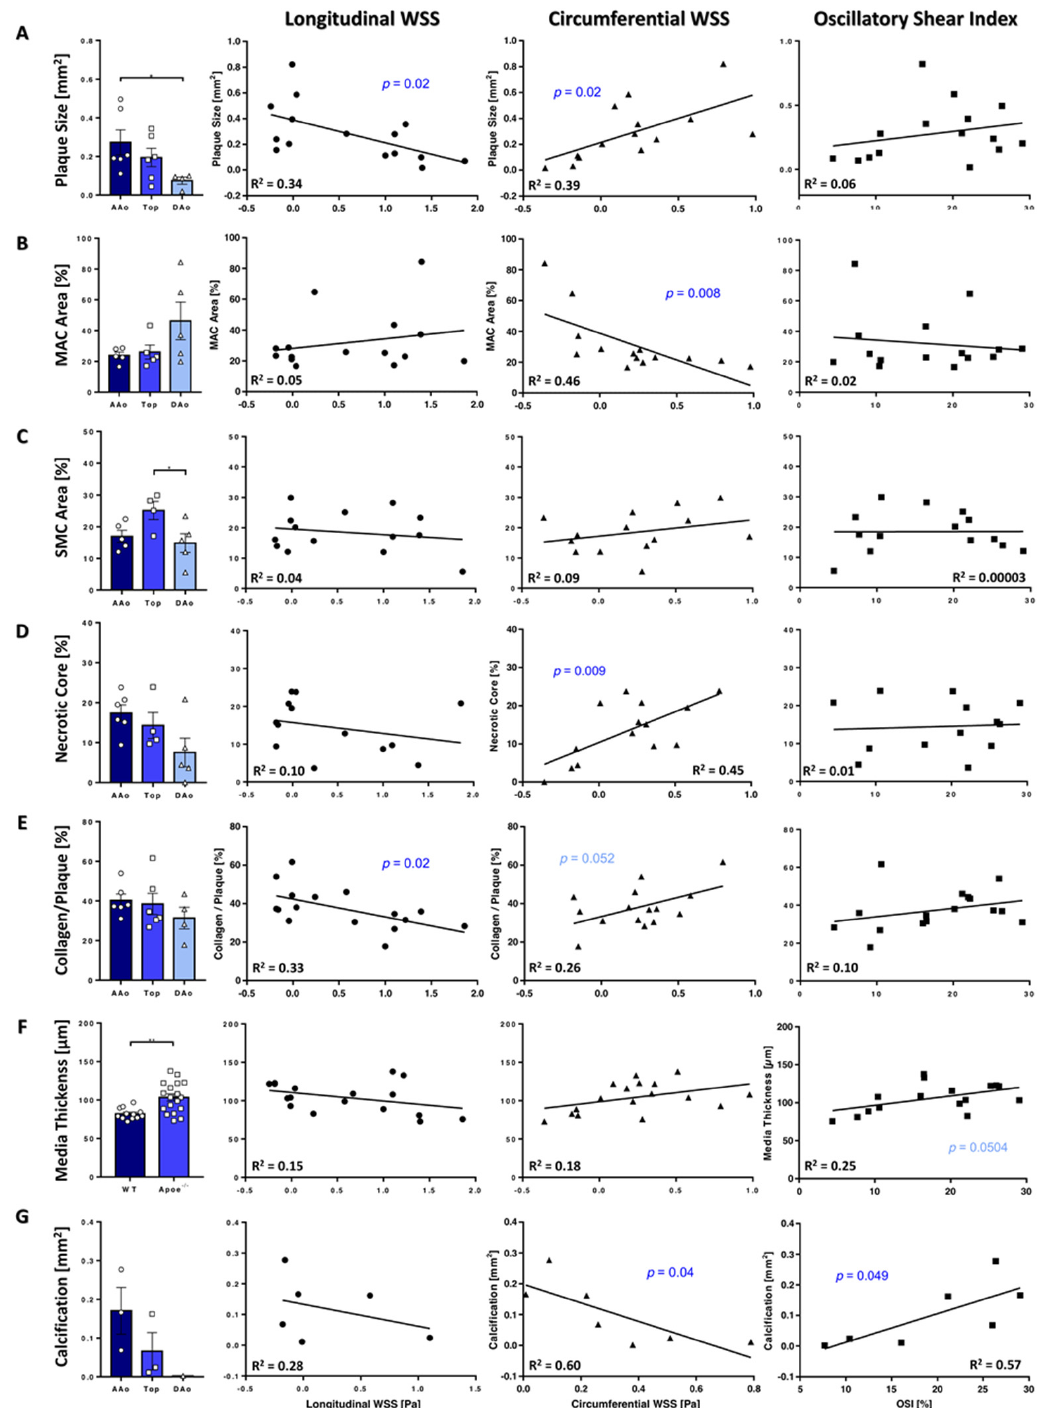
Figure 7. Plaque characteristics correlate with WSS values. ( A ) Plaque size was significantly smaller in the DAo compared with the AAo ( p < 0.05, *). A correlation was found with longWSS and circWSS. ( B ) Relative MAC area. A correlation with circWSS was observed. ( C ) SMC area in atherosclerotic plaques. In the top region, a significantly higher SMC content was observed compared with the DAo ( p < 0.05, *), but no correlation with WSS was found. ( D ) Necrotic core area showed no regional differences but positively correlated with circWSS. ( E ) Collagen analysis in atherosclerotic plaques. A correlation with longWSS was found. ( F ) Media thickness was significantly increased in Apoe − / − mice ( p < 0.01, **), but no significant correlation with WSS was found. ( G ) Calcification: Larger areas were found in the AAo. A negative correlation was found with circWSS and a positive correlation with